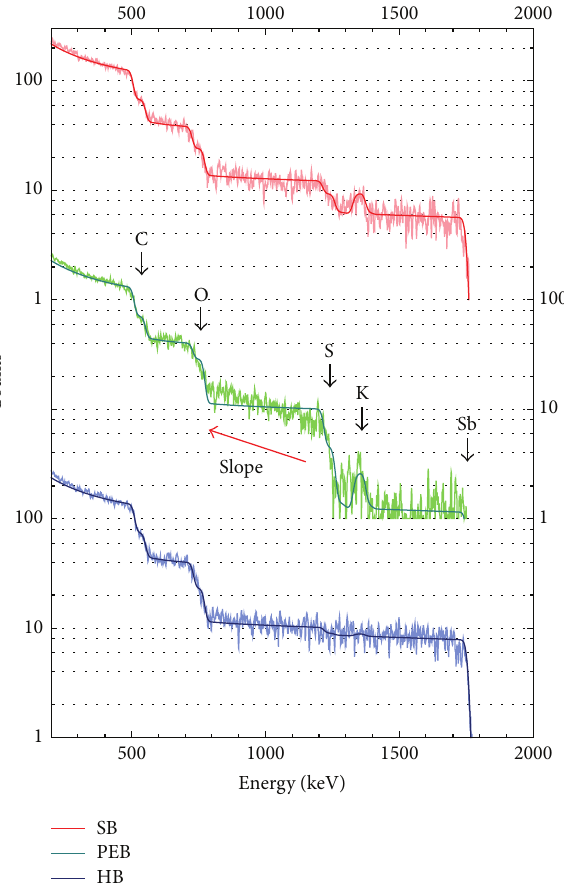
Figure 5: RBS spectra for Microposit/SU-8 samples with different SU-8 2010 treatments: SB (red), PEB (green), HB (blue), and SIMNRA software fittings (dark color